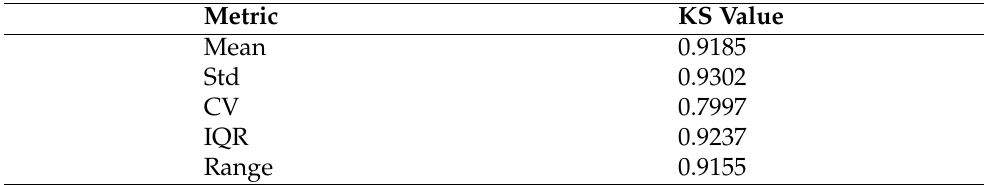
Table 2. Two-sided KS values for the metric distributions of high- and low-activity